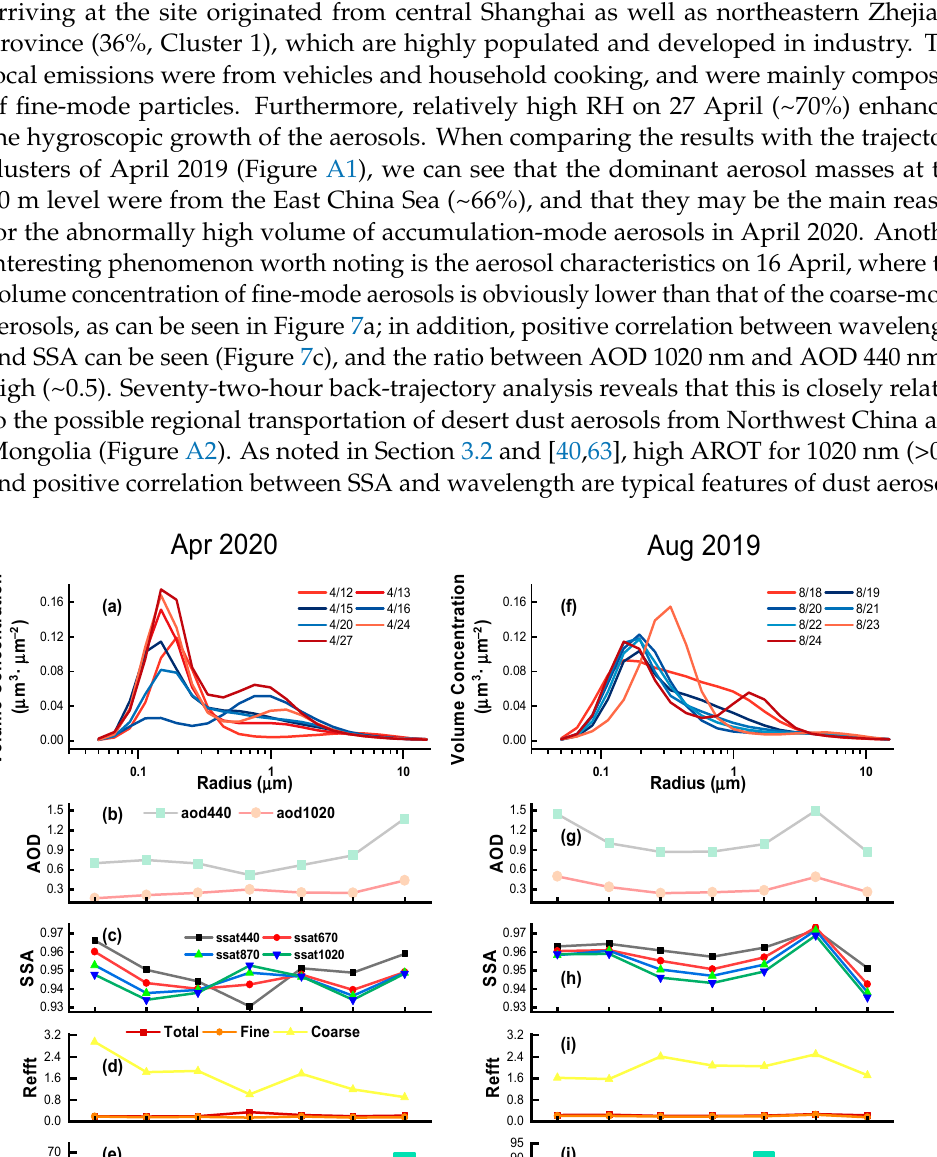
Figure 8. Clustering analysis of backward trajectories of episode 1 ( a , c ) and episode 2 ( b , d ). The first and second rows represent trajectories arriving at the Nanjing site at the levels of 50 and 1500 m above sea level, respectively. The number beside each trajectory cluster denotes the contribution of the air mass alongside the corresponding trajectory. The base map is supported by GISUNI.